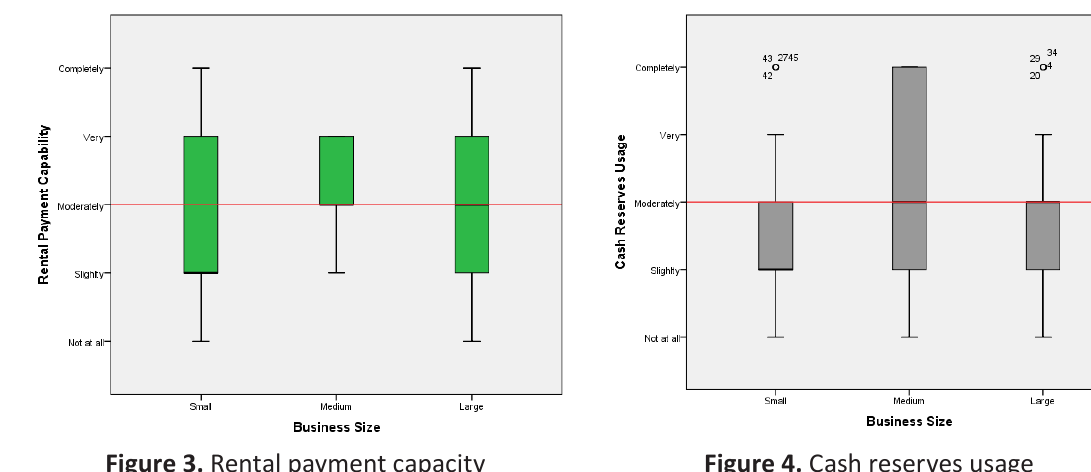
Figure 1. Failure perceptions Figure 2. Support from solidarity packages